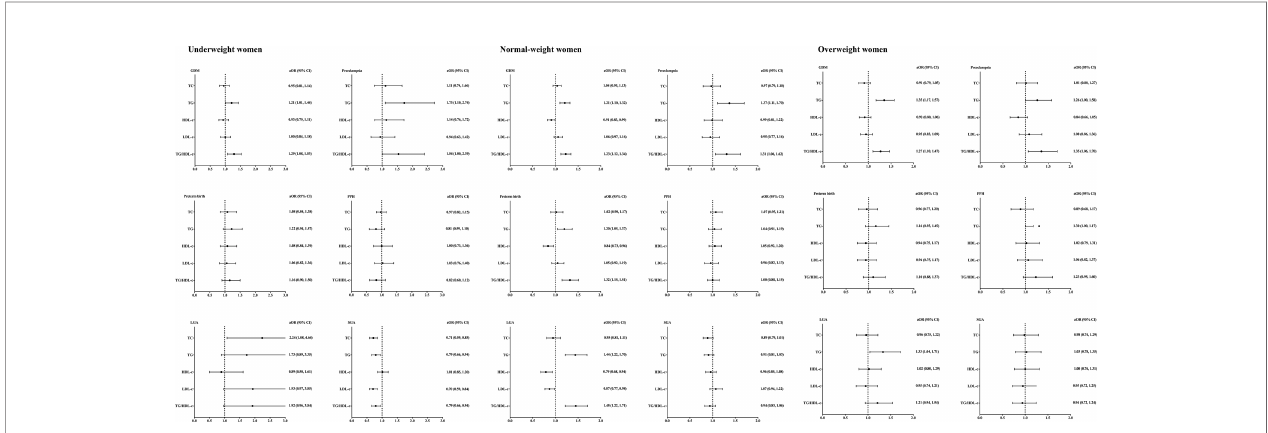
FIGURE 2 | Lipid pro fi les during second trimester and pregnancy complications strati fi ed by pre-pregnancy BMI. BMI, body mass index; aORs, adjusting odd ratios; CI, con fi dence interval; GDM, gestational diabetes; PPH, postpartum hemorrhage; LGA, large for gestational age; SGA,small for gestational age. Included subjects were grouped into underweight (<18.5 kg/m 2 ), normal-weight (18.5-22.9 kg/m 2 ), and overweight ( ≥ 23 kg/m 2 ) by BMI before conception based on the WHO criteria for Asian populations. All ORs were adjusted for maternal